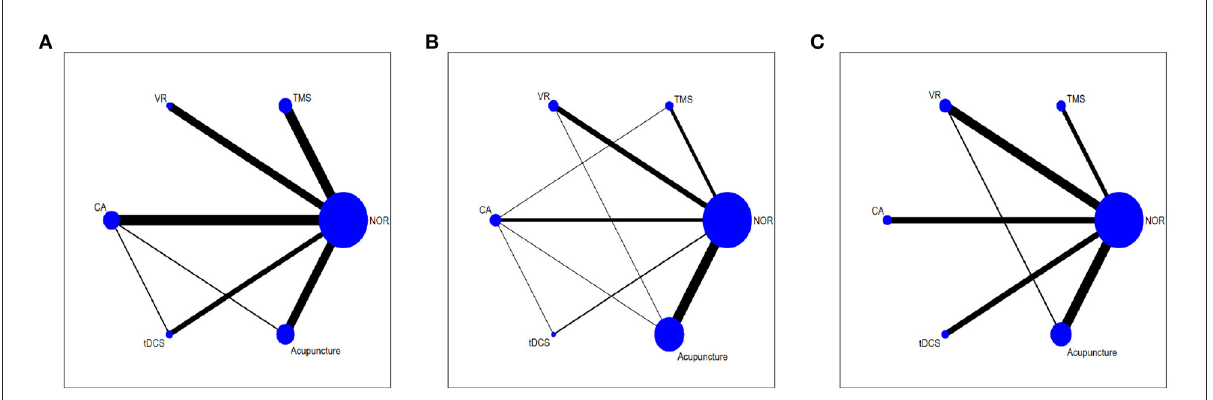
FIGURE3 Network meta-analysis diagrams of eligible comparisons. (A) MOCA, (B) MMSE, (C) BI. Width of the lines is proportional to the number of trial. Size of every circle is proportional to the number of randomly assigned participants (sample size). TMS, Transcranial Magnetic Stimulation; VR, Virtual Reality Exposure Therapy; CA, Computer-assisted cognitive rehabilitation; tDCS, Transcranial Direct Current Stimulation; Acu, Acupuncture; NOR, Normal rehabilitation (including conventional rehabilitation and routine cognition